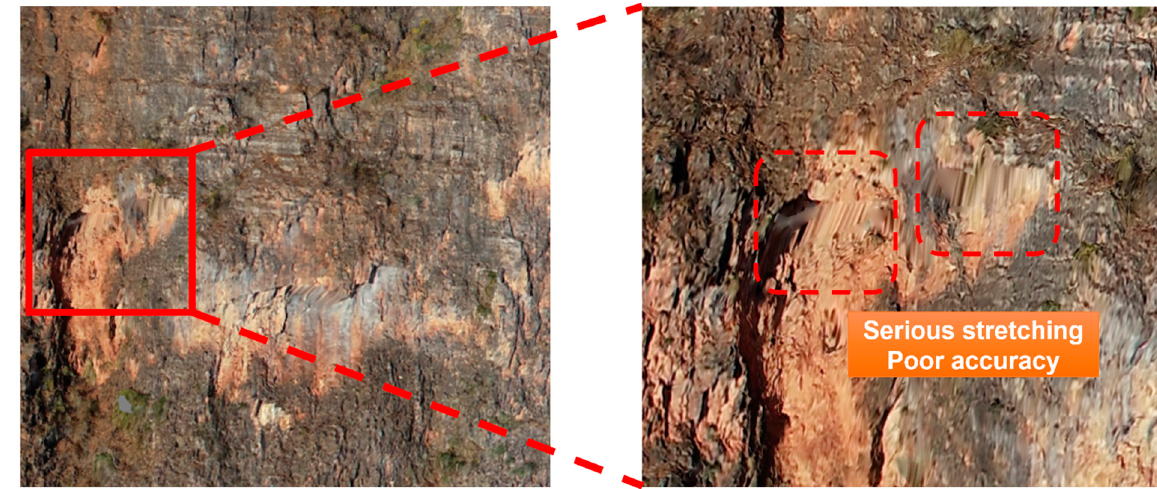
Figure 7. Distortion of the drone 3D model in the depressed area.